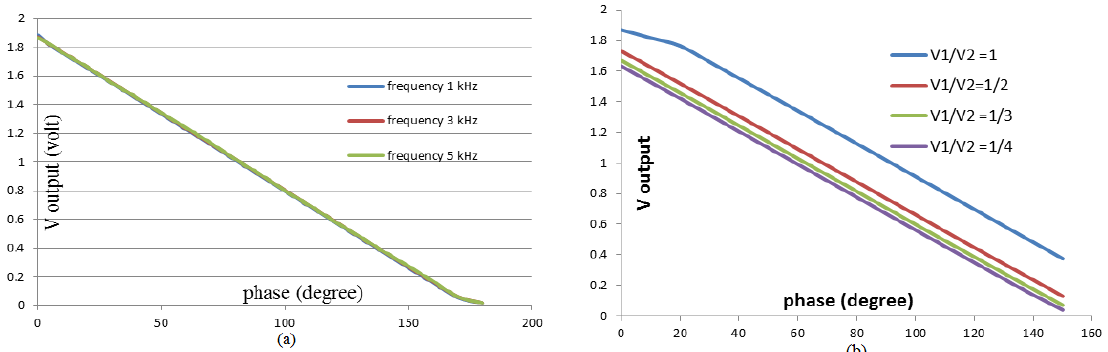
Figure 11. ( a ) The relation of the linearity of phase differences and voltages from signals detector with the same amplitude. ( b ) The linearity graph of phase detector’s voltages to the phase differences for two different signal amplitudes.